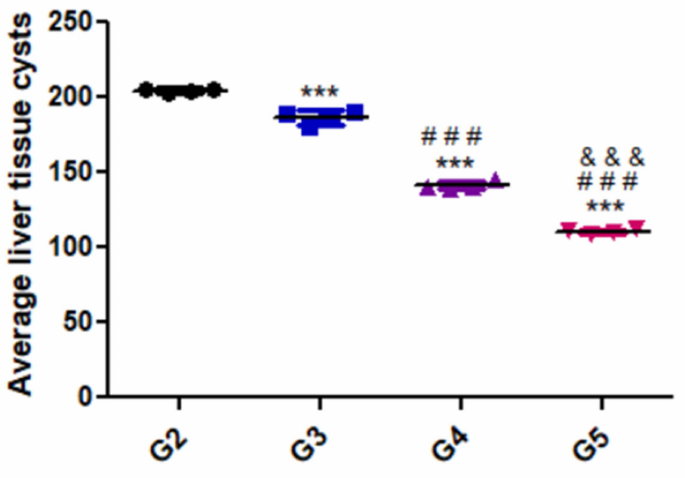
Figure 2. Average liver tissue cysts of the different experimental groups. Data are expressed as means ± standard deviations. Significant differences (G2 vs. other groups are marked by asterisks), (G3 vs. G4 and G5 are marked by #), ((G4 vs. G5 are marked by &) all through one-way ANOVA